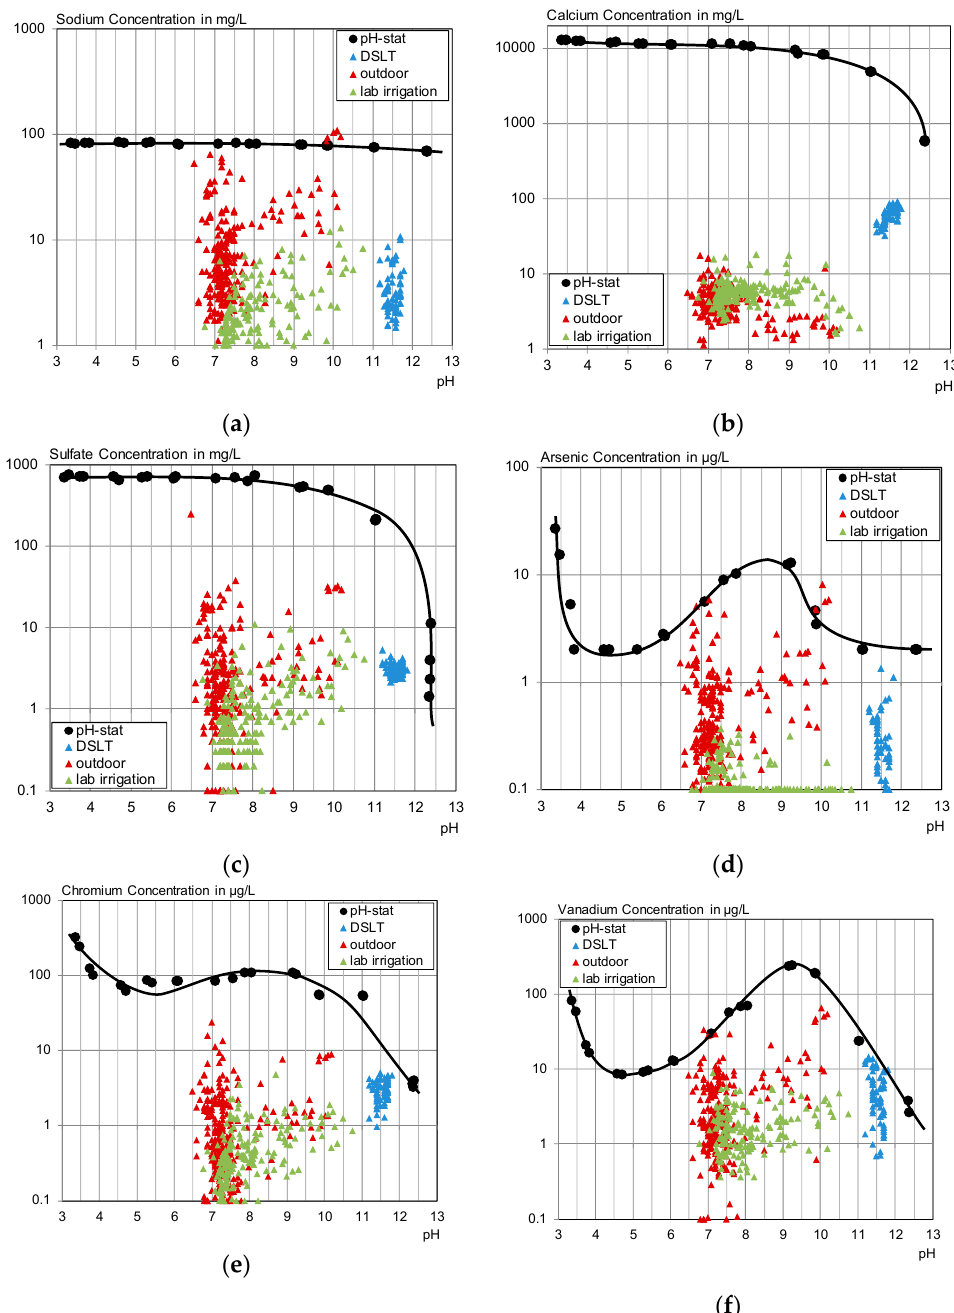
Figure 22. pH-dependent leaching of selected substances from C 3 compared to the leachate concentrations of the DSLT, the laboratory irrigation and the outdoor testing. ( a ) Sodium; ( b ) calcium; ( c ) sulfate; ( d ) arsenic; ( e ) chromium; ( f ) vanadium.